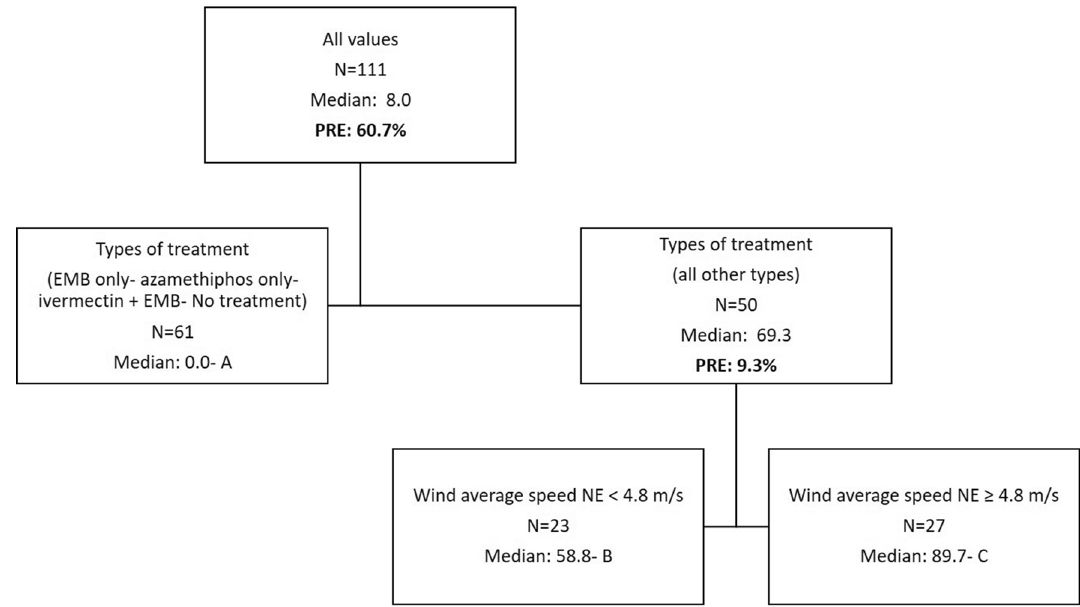
Figure 9. DTA with sums of normalized rates of multi-chemical usage as a dependent variable with a focus on wind effects. Predictors include: Bay, Company, usage of lumpfish, numbers of fish, types of treatment, stocking